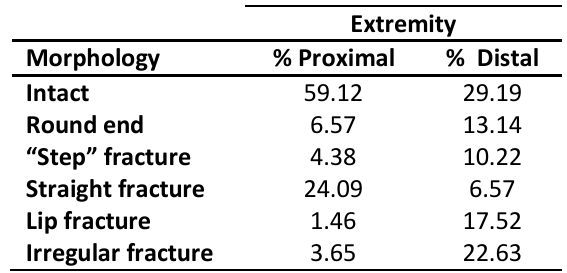
Table 3: Extremity morphologies observed on the Dentalium sp. from Rochereil.